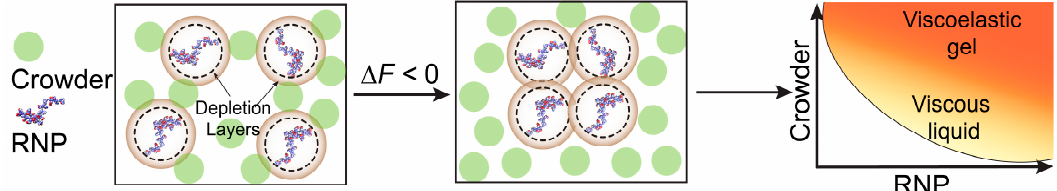
Figure 6. Schematic representation of depletion attraction: Proposed model showing crowder-mediated overlap of depletion layers as a driving force underlying RNP droplet formation and maturation into a gel-like phase in a crowded medium.